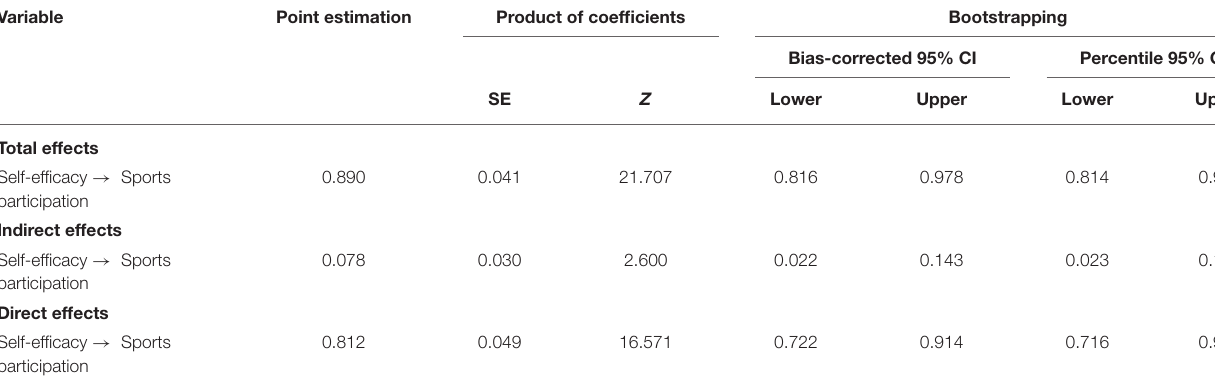
TABLE 3 | Results of the mediating effect of sports participation